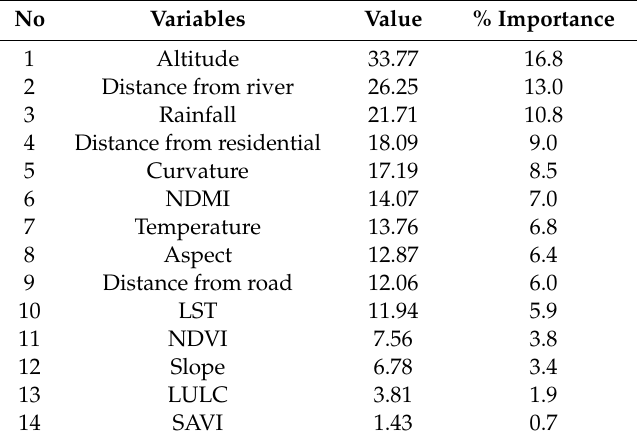
Table 5. Percentage importance of predictor